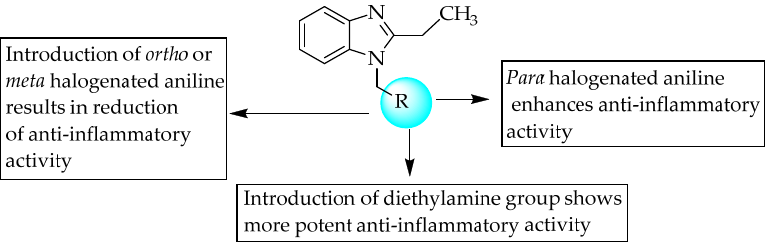
Figure 30. SARs of Mannich bases of 1-(N-substituted amino)methyl-2-ethylbenz–imidazoles. In 2010, Gaba et al. studied the anti-inflammatory activity of 5-substituted-1-(phenylsulfonyl)-2-methyl benzimidazole derivatives using carrageenan-induced paw oedema in a rat model at 200 mg/kg body weight. Compounds substituted with ortho amino (37% reduction) and para amino (39.7% reduction) groups at R (Figure 31) exhibited good anti-inflammatory activity with low ulcerogenic potential due to being neutral molecules bearing –NH 2 . The introduction of –CH 2 between the amino and aryl moieties of benzimidazole did not influence the anti-inflammatory action [49]. The SARs of the compounds are shown in Figure 31.